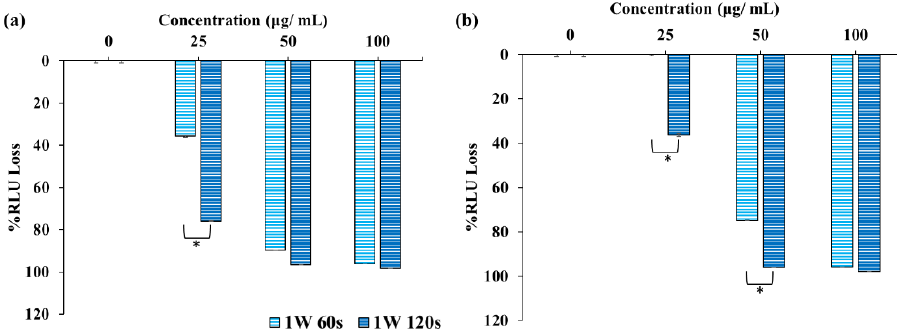
Figure 6. Percent loss of RLU following exposure to increasing VMWNPs concentrations and laser exposure for 60 or 120 s for ( a ) OxS and ( b ) OxR CT-26 cells. * Indicates statistical significance between 60 and 120 s ( p < 0.05).